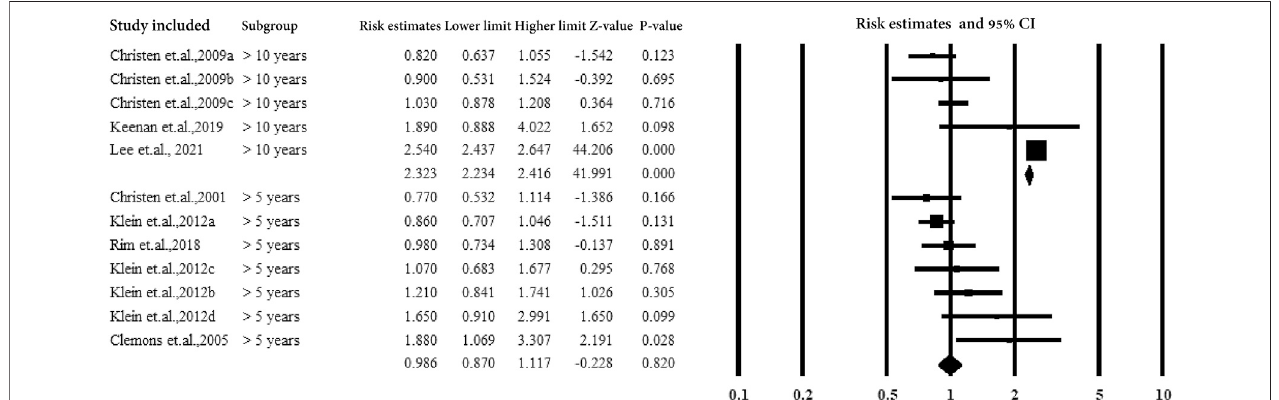
FIGURE 8 | Summarized subgroup analysis according to the study design.